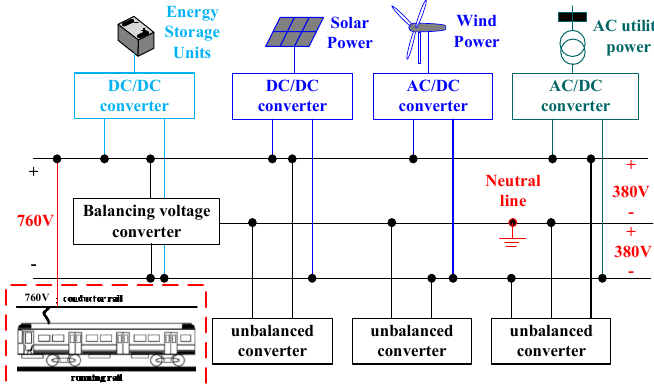
Figure 1. Basic circuit structure of a DC microgrid.